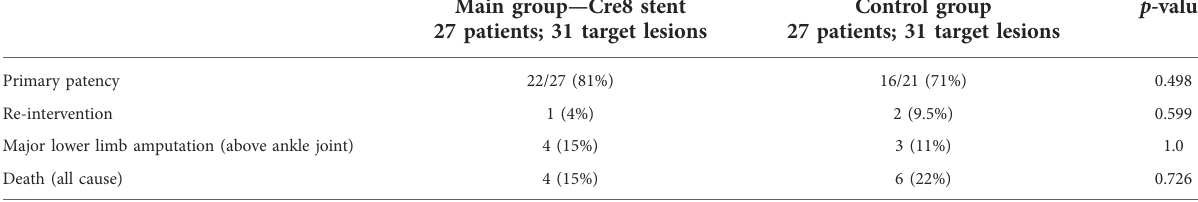
TABLE 3 Outcomes of interest per group over a 12-month follow-up.